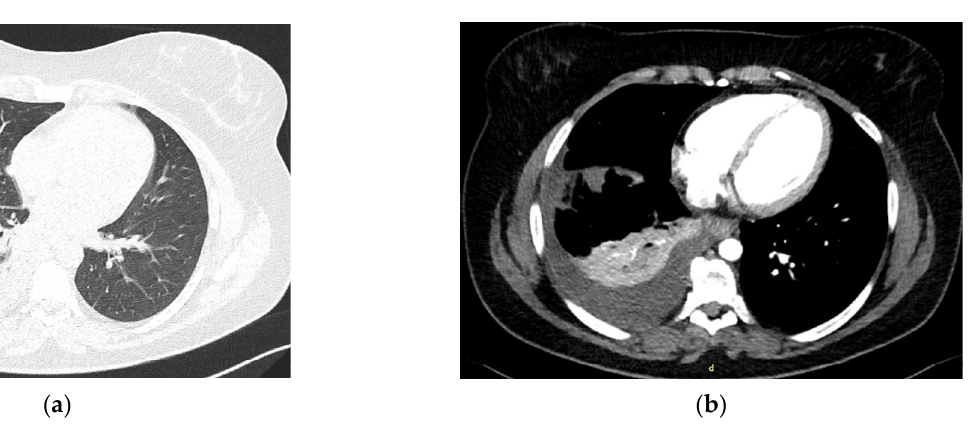
aorto-iliac Dacron graft bypass surgery (this fi gure). The postoperative evolution was favorable. The